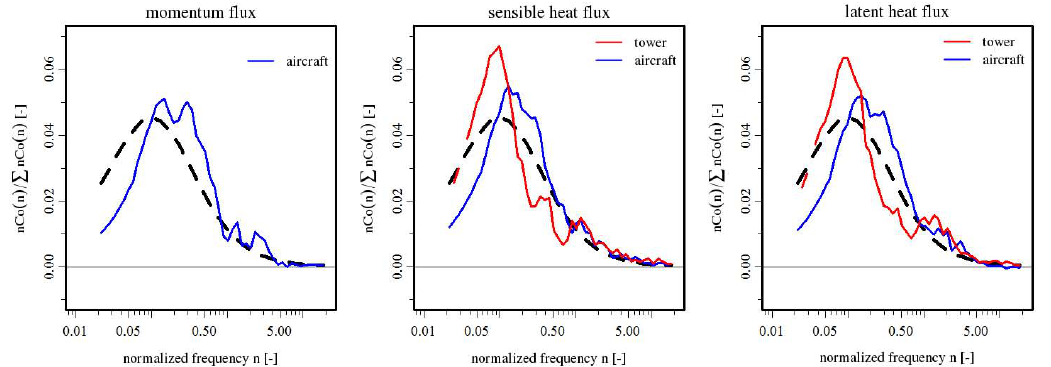
Fig. 5. Average cospectra of all measurements between tower and WSMA. Also shown is the reference cospectrum of Massman and Clement (2004, dashed line). Additional information is given in the